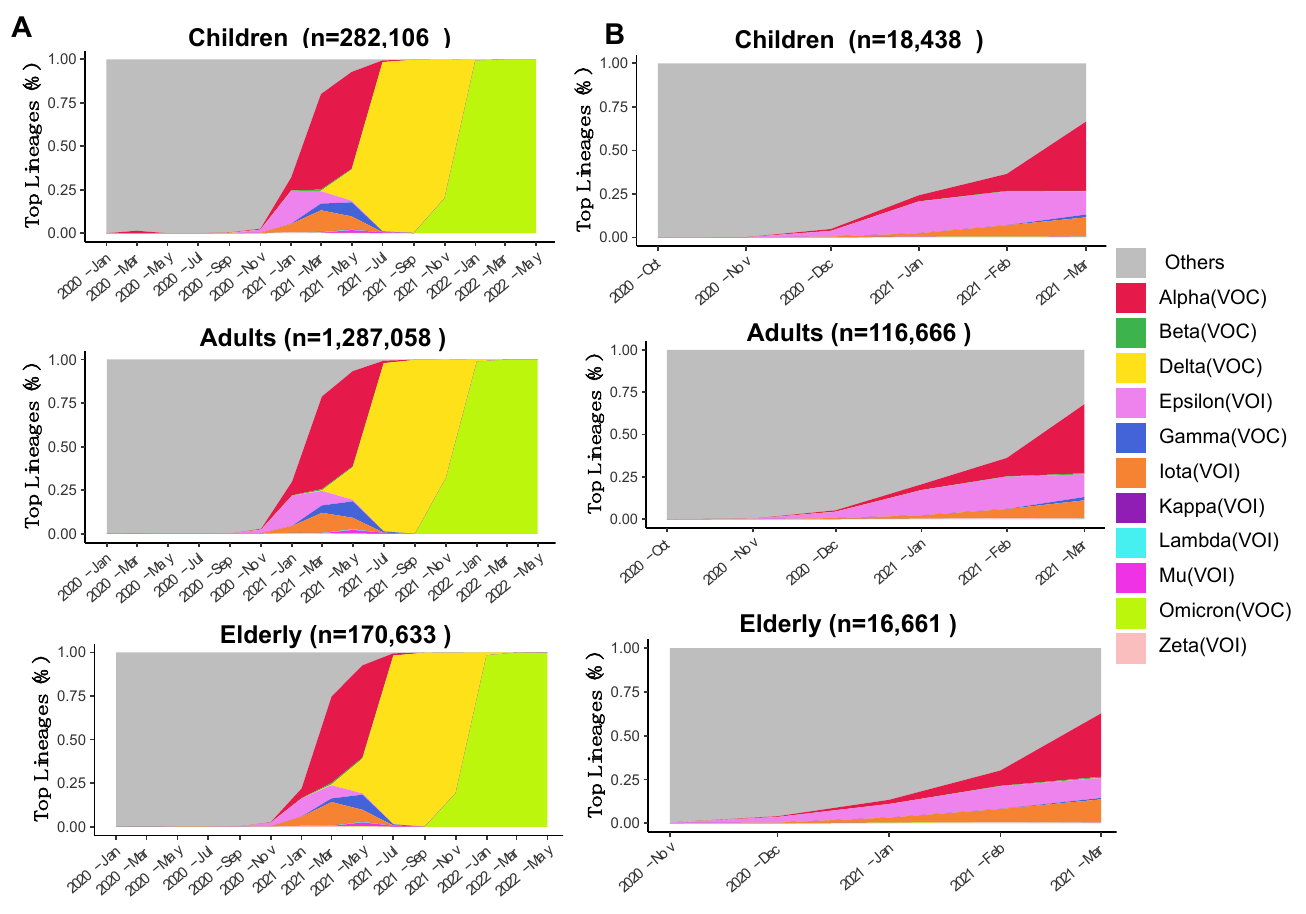
Figure 2. Area plots reflecting (different colors represent variants of concern see legend for details) the relative abundance of variants of concern and variants of interest collected in the USA over time. ( A ) Frequency of indicated VOCs and VOIs over time in specimens collected between January 2020 and May 2022 in the USA (n = 1,739,797 sequences from GISAID as of 31 May 2022). ( B ) Frequency of indicated VOCs and VOIs over time in specimens collected between November 2020 and March 2021. Specimens were divided into three age groups: children (up to 18 years), adults (18–64 years), and the elderly (65 years or more). The number of sequences per age group is indicated above each plot. Each subset of genomes was processed separately using the ViralVar “Lineage Dynamics” module.